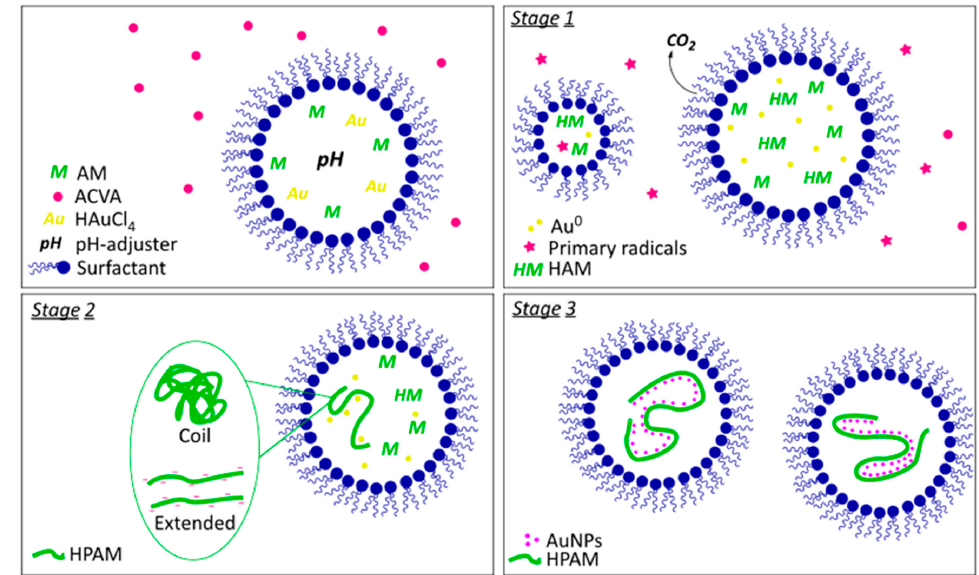
Figure 1. Representation of the reaction process stages. Stage 1: hydrolysis of some monomers. Oxidation of hydrolyzed monomers to CO 2 and gold reduction. Initiation of polymerization followed by the propagation step. Stage 2: Growth of nanoparticles in the polymeric template (coil conformation at pH of 5 and 7, extended conformation at pH of 14). Stage 3: nanocomposite